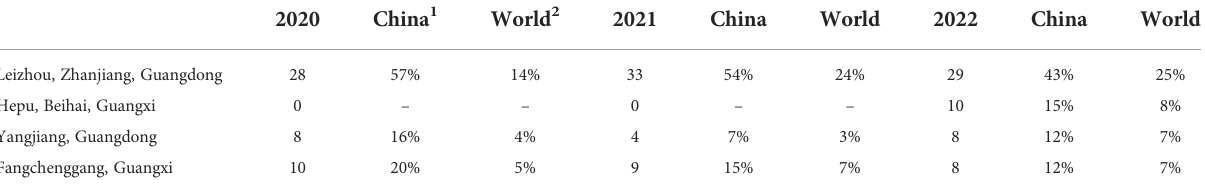
TABLE 2 Wintering population of Spoon-billed Sandpipers in the top four important wintering sites in southern